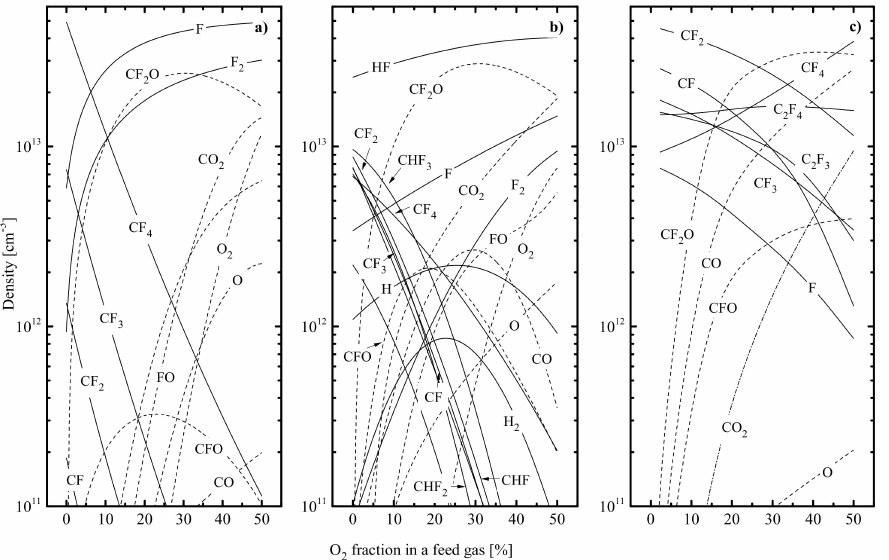
Figure 8. Densities of neutral species in 50% CF 4 + O 2 + Ar ( a ), 50% CHF 3 + O 2 + Ar ( b ) and 50% C 4 F 8 + O 2 + Ar ( c ) plasmas at p = 6 mTorr, W = 700 W and W dc = 200 W. The change in y O range of 0–50% corresponds to the full substitution of Ar for O 2